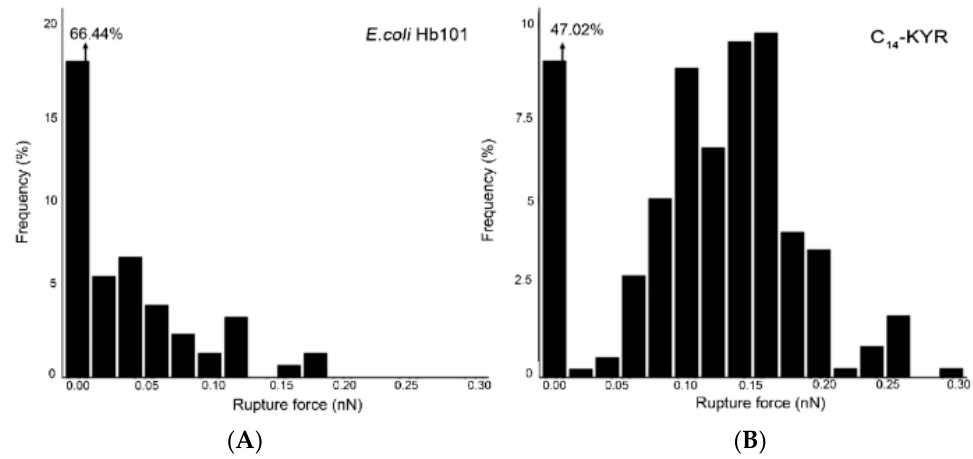
Figure 6. Histograms of frequency distribution of rupture force between the AFM tip and the E. coli HB101 in the absence ( A ) and presence of C 14 -KYR ( B ). For the untreated cell, the ruptured force ranged from ~0.02 to 0.18 nN. For the C 14 -KYR-treated cell, the rupture force ranged from ~0.02 to 0.3 nN. Each histogram corresponds to approximately 400 of single force curves.